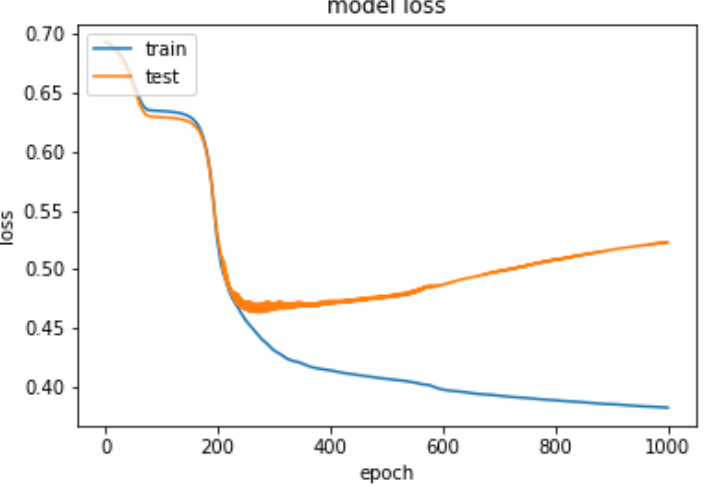
Figure 13. LSTM-AR- results (training dataset = 80%, testing dataset = 20%): Model Loss versus epochs.